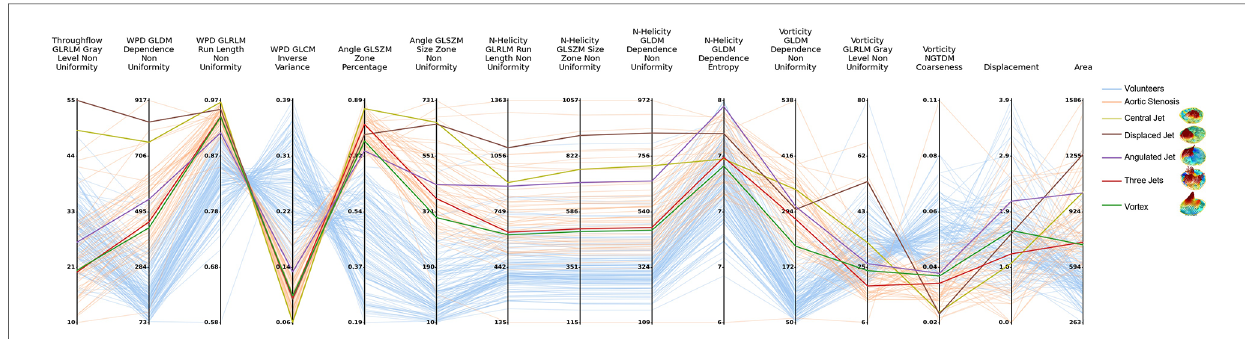
FIGURE 7 Parallel coordinates plot of selected radiomics features on data from all cases on slice A1.1. Features are extracted on the peak systolic phase with maximum volume fl ow rate. Examples of different central jet, displaced jet, angulated jet, three jets and vortex are